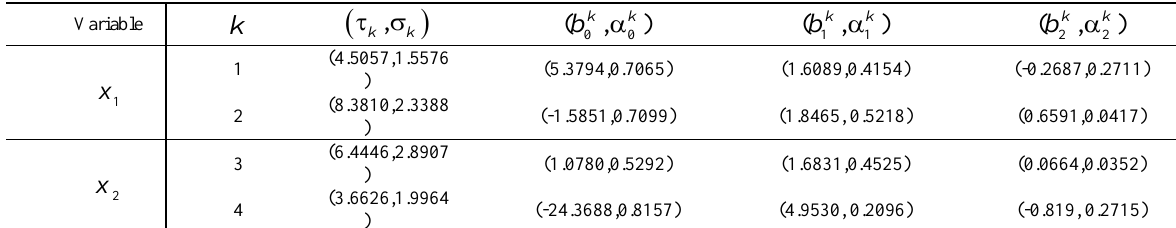
Table 1. Premise and consequence parameters obtained using FWLP method.